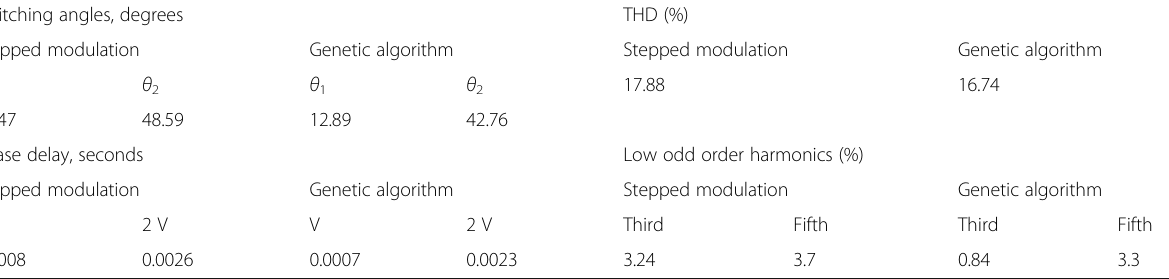
Table 4 Comparison of THD, switching angles, phase delay, and low-order odd harmonics of five-level inverter obtained by step modulation method and optimization technique Switching angles, degrees THD (%) Stepped modulation Genetic